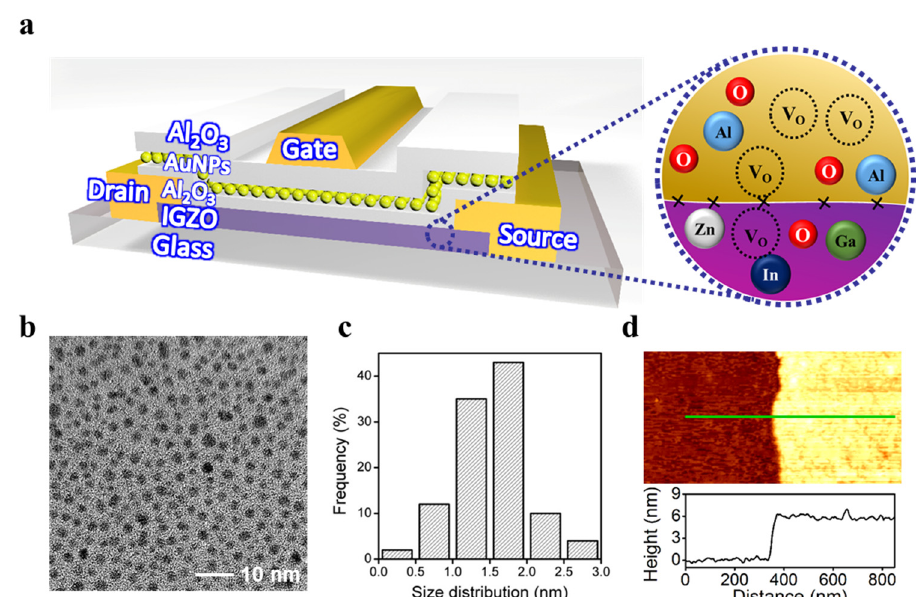
Figure 1. Non-volatile memory device based on the floating gate of monolayer AuNPs. ( a ) A schematic layout of the proposed floating gate NVM device. ( b ) A TEM image of monolayer AuNPs, utilized as a floating gate layer (scale: 10 nm). ( c ) A size distribution bar graph of the proposed monolayer AuNPs layer. ( d ) An AFM analysis of proposed monolayer AuNPs with a thickness distribution scale.